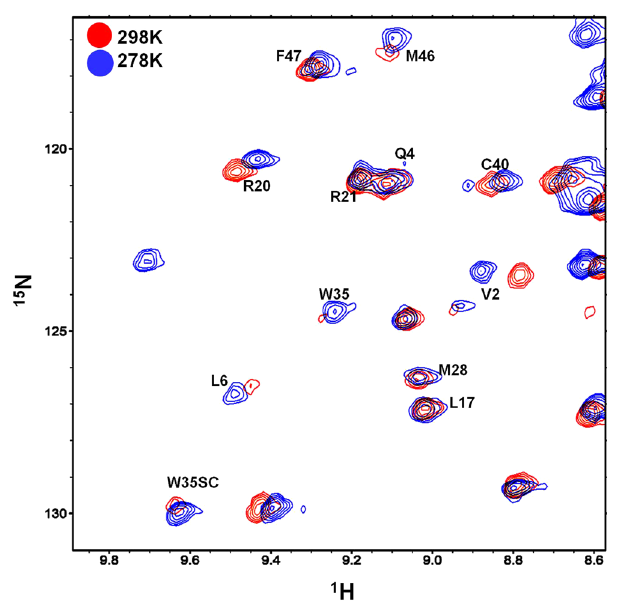
Figure 8. Temperature dependence of the backbone amides. Spectra displaying peak intensities of some of the backbone amides of the Grb2 SH3C domain in the SLP65-Grb2-Vav trimeric complex at room temperature (colored red), overlaid on the spectra acquired at 10 °C (colored